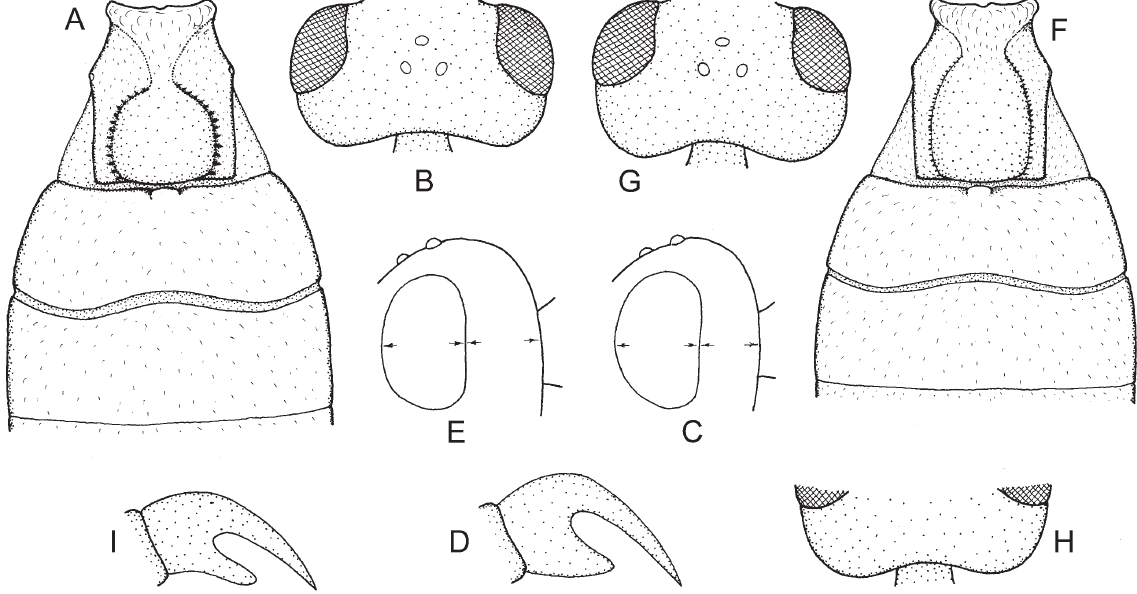
Fig. 53. — A-D. Bracon ( Glabrobracon ) xanthogaster Nees, 1834, ♀. A . Tergites 1-3. B . Head in dorsal view. C . Head in lateral view. D . Claw. — E . Bracon ( Glabrobracon ) caudiger Nees, 1834, ♀ / ♂, head in lateral view. — F-I . Bracon ( Glabrobracon ) pineti Thomson, 1894, ♀. F . Tergites 1-3. G . Head in dorsal view. H . Hind half of head in dorsal view. I .